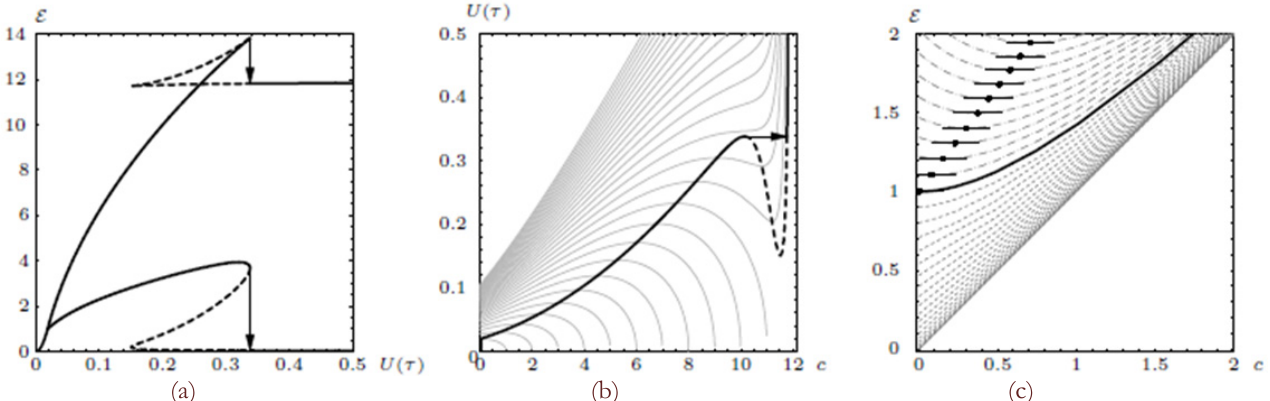
Figure 10: In (b) quasi static evolution of the system of Fig.8 in the plane {c,U}. Solid line: metastable states, shaded line: unstable states. In (a) total energy and elastic energy along the path of figure (b). In (c) total energy for increasing values of the given displacement U as a function of c.